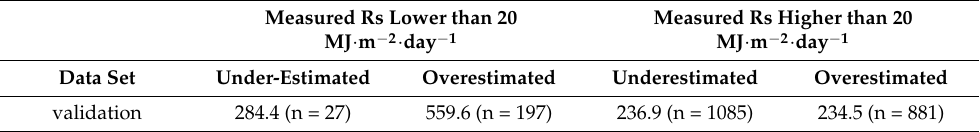
Figure 3. Solar radiation estimated by proposed model at Arequipa station versus measured values in calibration and validation sets. Table 7. RMSEs (J · cm − 2 · day − 1 ) and number of data points (proposed model) in under- and over- validation